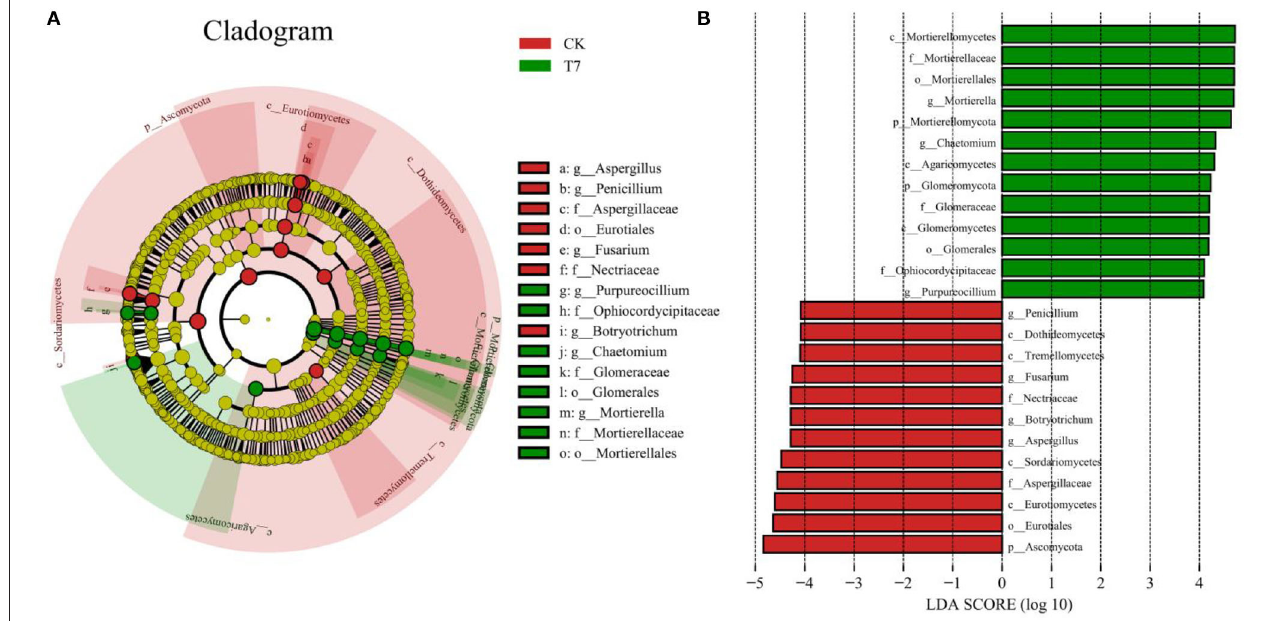
FIGURE 7 | LEfSe comparison of fungal communities between rhizosphere soils of the control (CK) and the optimal fertilization treatment T7. (A) Cladogram of taxonomic levels from phylum to genus and (B) taxa with LDA values > 4. Note: (a) Composition of fertilization treatments: CK, N 0 P 0 K 0 ; T7, N 3 P 1 K 3